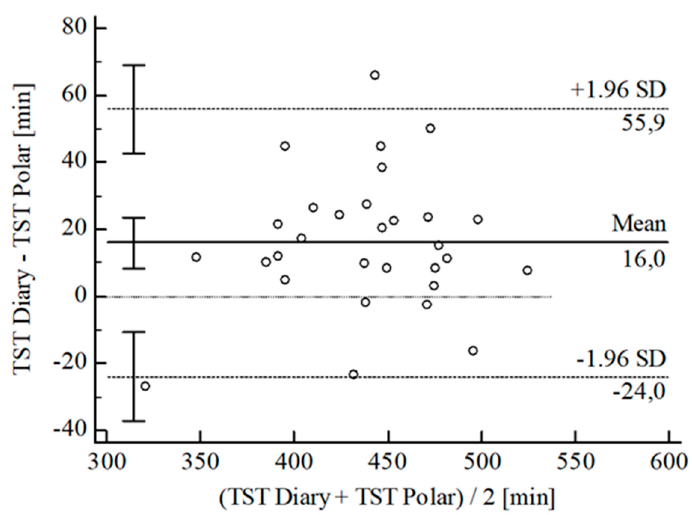
Figure 8. Bland-Altman plot for TST Polar ® vs. diary.